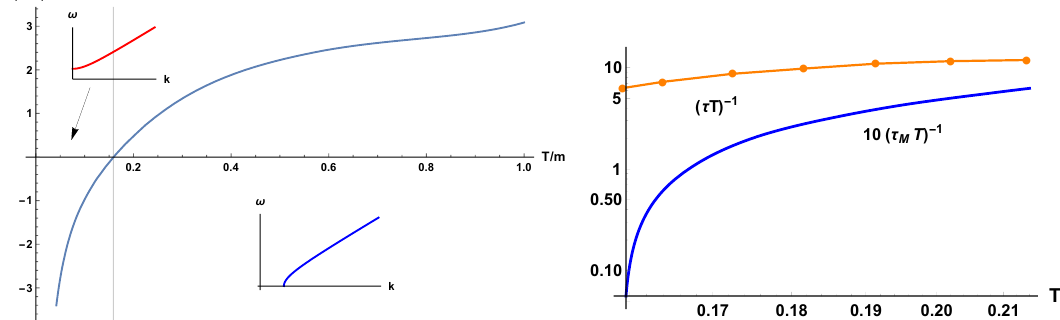
Figure 16 . Left: the Maxwell relaxation time (cid:28) M = (cid:17)=G 1 in function of the dimensionless temperature T=m . Roughly the change of sign of the Maxwell timescale appears when the dispersion relation of the shear modes switch from massive particle type (red inset) to k-gap type (blue inset). Right: a comparison between the Maxwell relaxation time (cid:28) M and the numerical